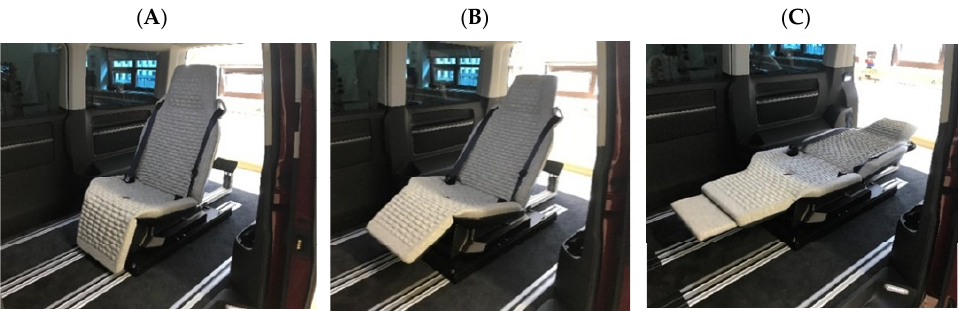
Figure 1. Prototype seat and environment in the upright, reclined and flat seat positions. ( A ) Upright. ( B ) Reclined. ( C ) Flat.